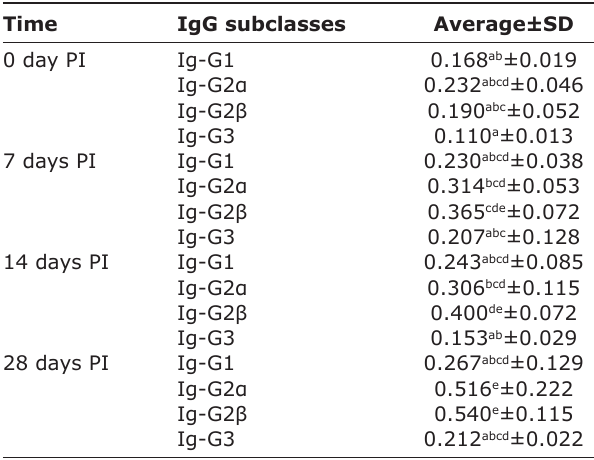
Table-1: Optical density values of anti- T. cati mice sera of treatment groups based on time and IgG subclasses